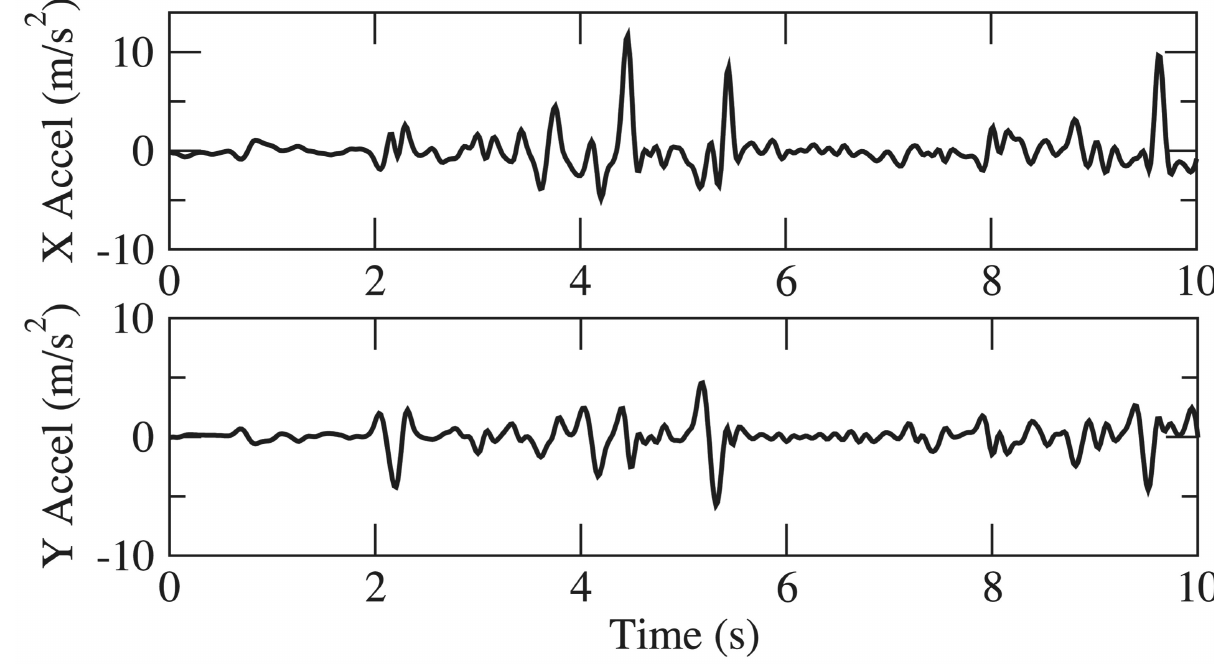
Figure 9. Acceleration in walking, Unified Parkinson’s Disease Rating Scale (UPDRS) gait score =